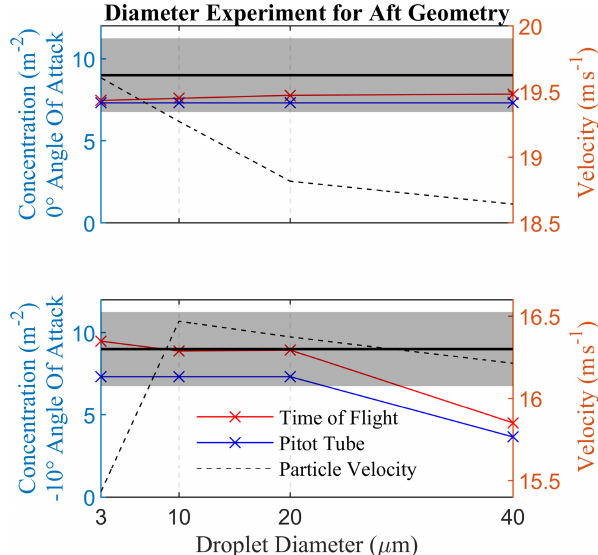
Figure 6. Calculated droplet concentration against droplet diameter for two different AoAs. The solid black line shows the input con- centration, and the black shaded region around it represents ± 25% of the input. The red and blue lines are the concentration data cal- culated using simulation equivalent droplet ToF and pitot tube air- speed, respectively. The black dotted line is the mean velocity of a droplet as its simulated trajectory crossed the UCASS sample